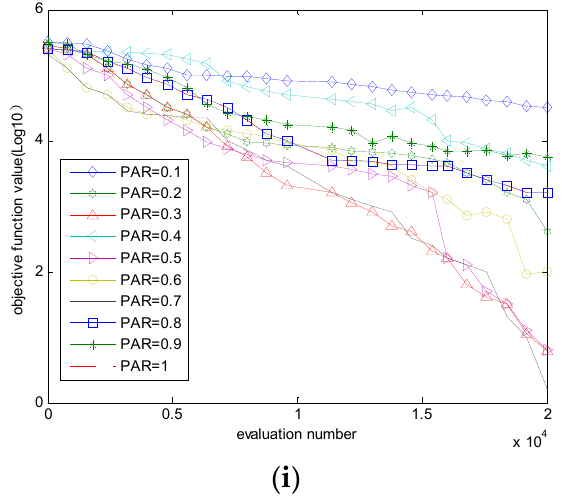
Figure 4. The optimization curve for different values of the parameter PAR: ( a ) f